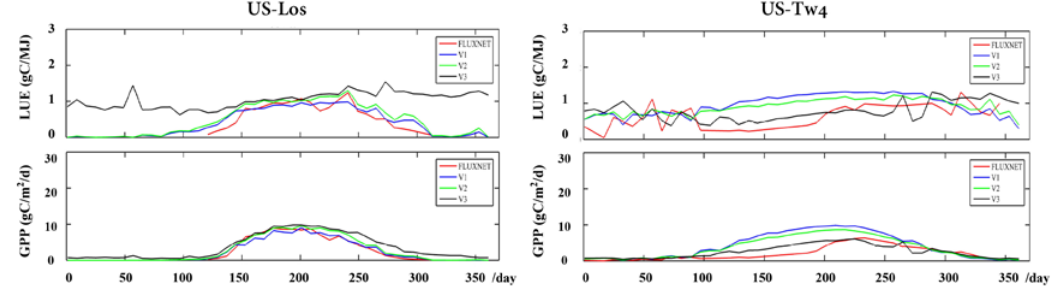
Figure 14. LUE and GPP curves in US-Los and US-Tw4. 596